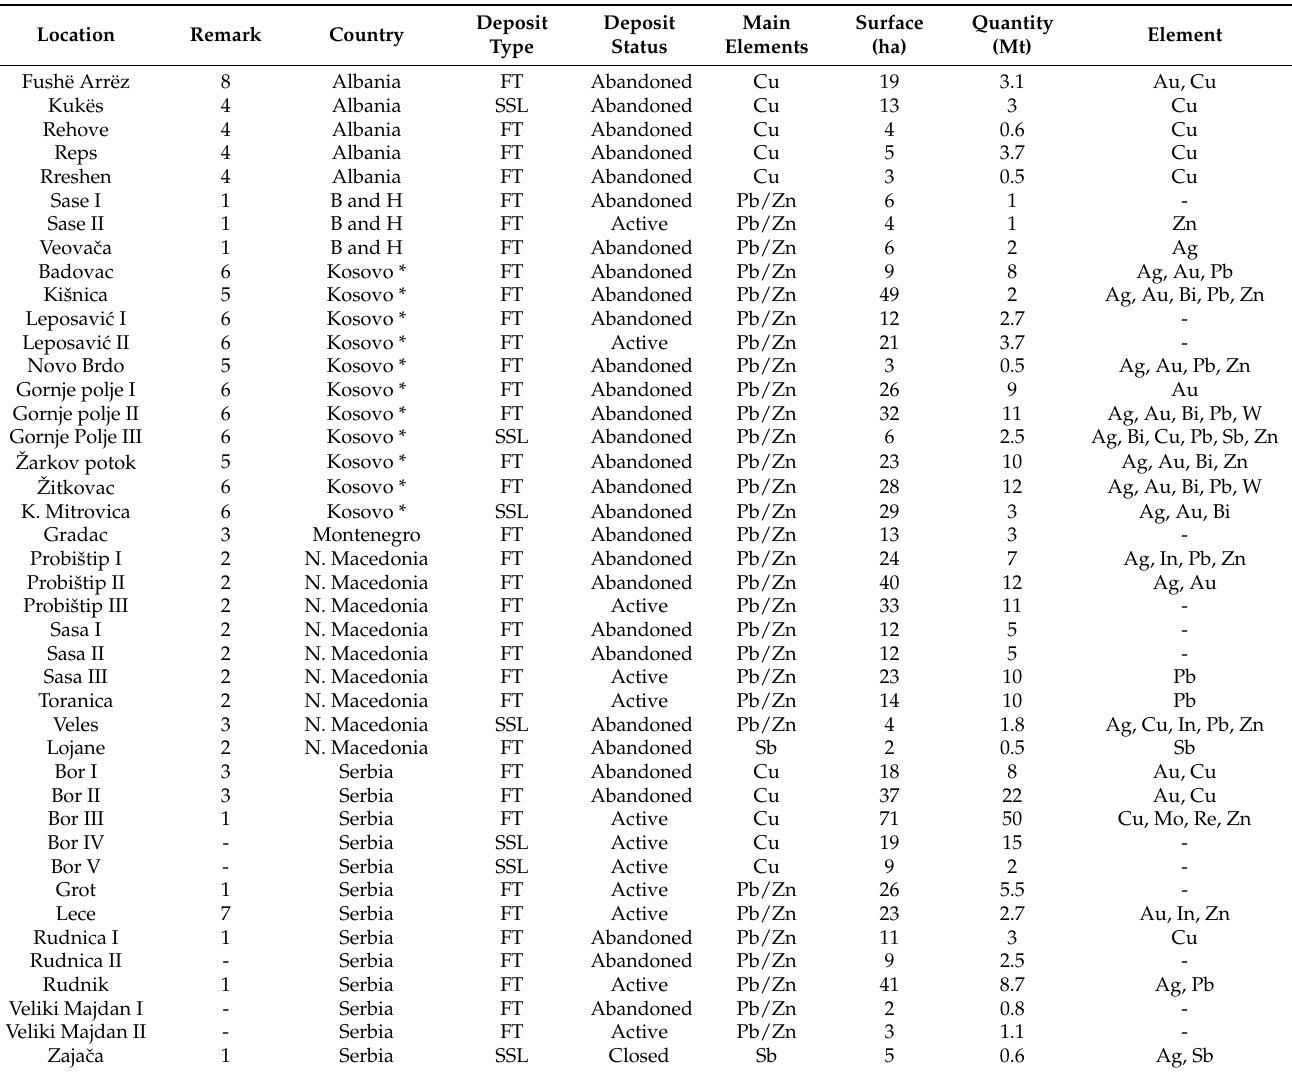
Table 1. Basic data of potentially prospective SRM